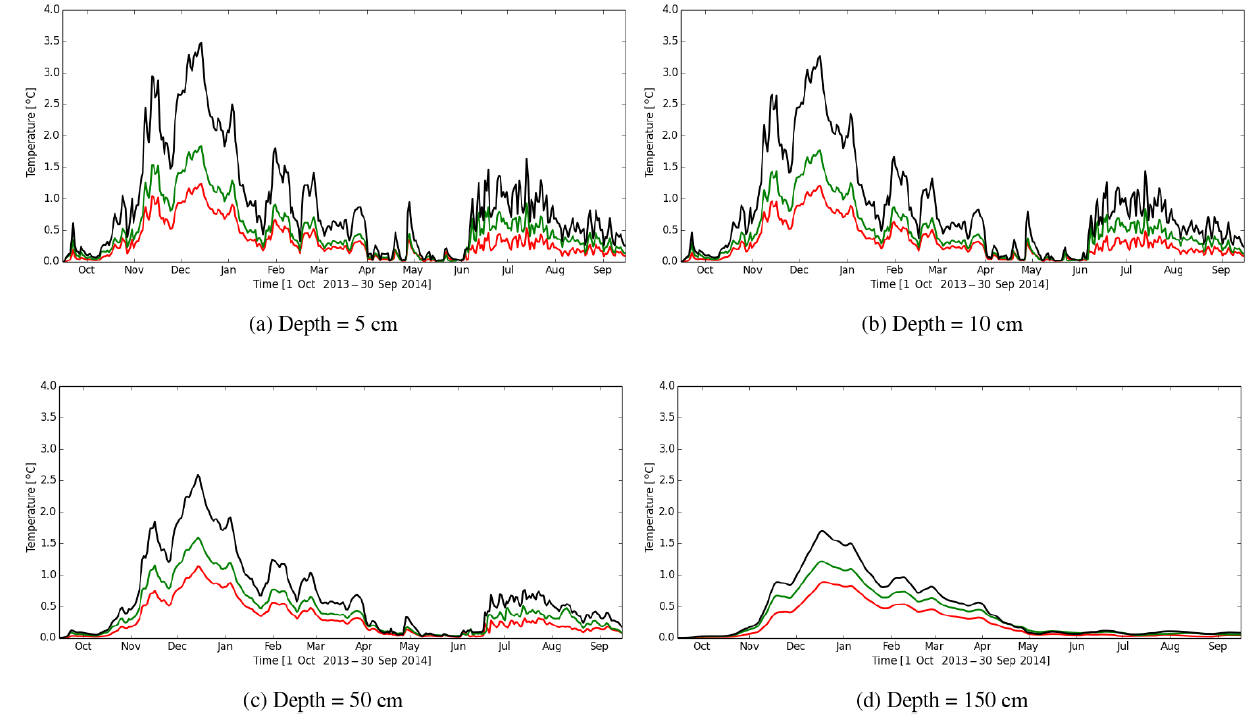
Figure E3. Spatiotemporal variability (standard deviation) in simulated soil temperature at Site D. Red, green and blue lines represent center, rim and trough respectively, and the black line represents the standard deviation across Site